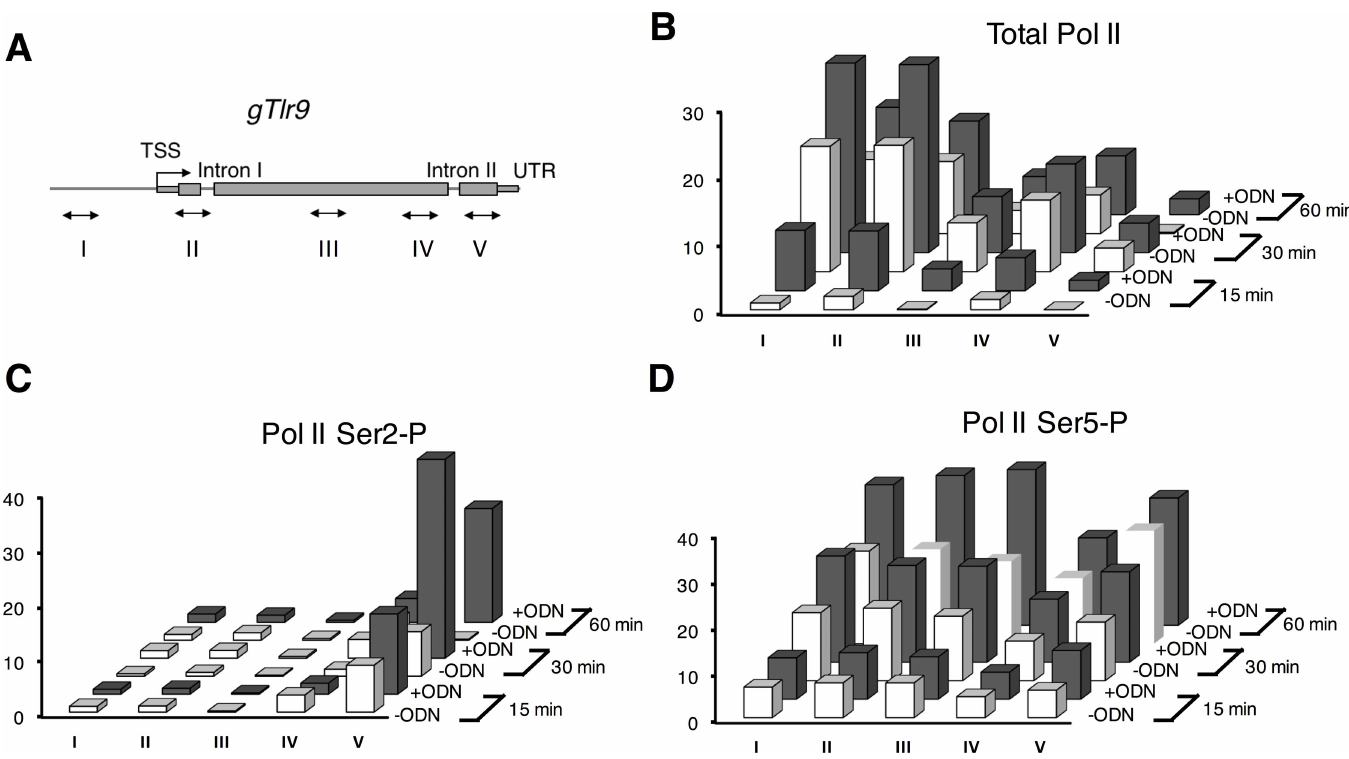
Fig 3. Increasing Pol II occupancy on gTlr9 gene after ODN stimulation. ( A ) Oligonucleotide sets used in ChIP assay for various regions of the gTlr9 gene are marked in Roman numerals. TSS, transcription start site; UTR, 3’ untranslated region. Occupancy of total Pol II ( B ), Pol II-CTD-Ser2 phosphorylated (Ser2-P) ( C ), and Pol II-CTD-Ser5 phosphorylated (Ser5-P) ( D ) on the gTlr9 gene. Results are presentedas the mean of triplicate samples. See Materials and methods for calculation of the percentage (vertical axis) of the ChIP data.